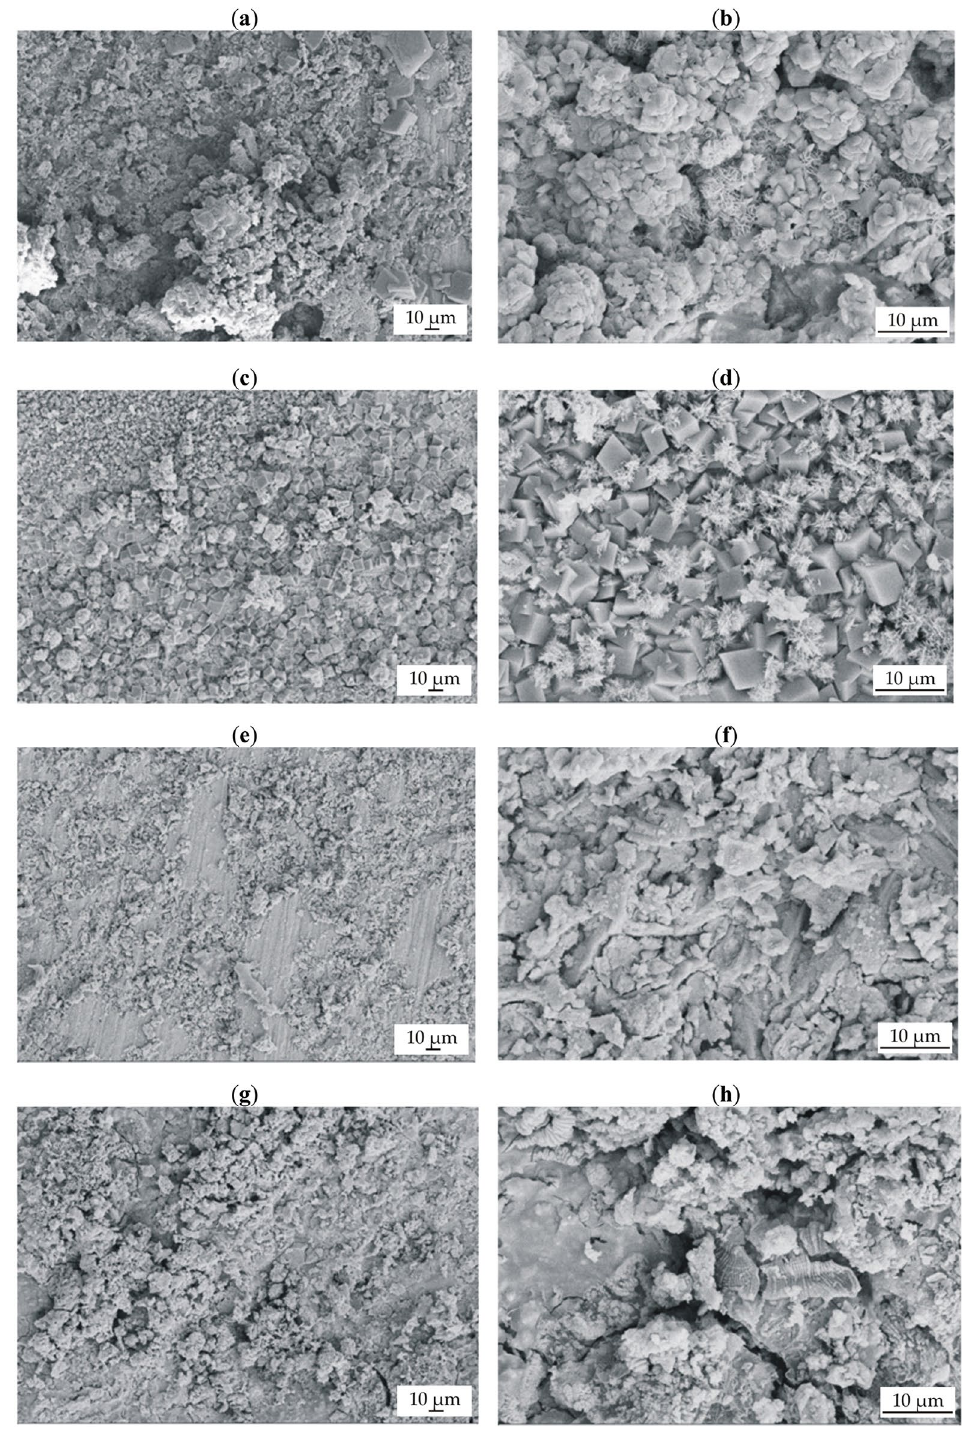
Figure 6. SEM images of samples’ surfaces with corrosion products after 48 h of immersion in Ringer’s solution at 37 °C for: ( a,b ) Ca 32 Mg 12 Zn 38 Yb 15 B 3 ; ( c,d ) Ca 32 Mg 12 Zn 38 Yb 14 B 2 Au 2 , and after immersion in PWE fluid: ( e,f ) Ca 32 Mg 12 Zn 38 Yb 15 B 3 ; ( g,h ) Ca 32 Mg 12 Zn 38 Yb 14 B 2 Au 2